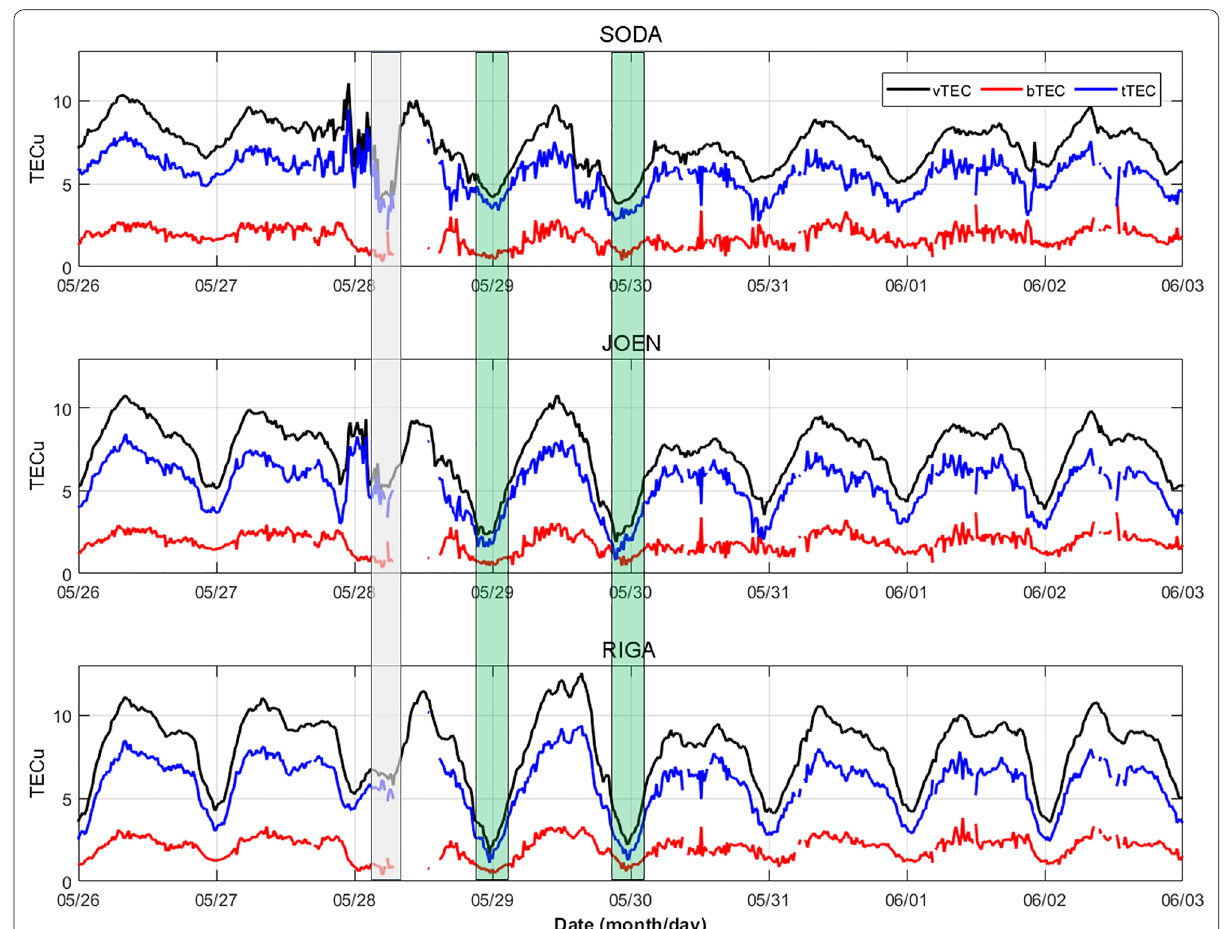
Fig. 11 vTEC (in black) as measured at SODA (67.4°N, 26.4°E), JOEN (62.4°N, 30.1°E) and RIGA (56.9°N, 24.1°E), from 26 May to 2 June 2017, in UT. SODA, JOEN and RIGA are the closest GNSS receivers to the pairs of magnetometers MUO–RAN, RAN–HAN and TAR–BRZ of the EMMA array, respectively, used to describe the latitudinal dependence of the plasmasphere dynamics as shown in Fig. 7. Corresponding values of bTEC (in red), as calculated through the IRI UP method, and tTEC vTEC bTEC (in blue), are also displayed. The gray shaded rectangle highlights the significant = − depletion of vTEC occurring in the first half of 28 May 2017, while the green ones highlight the very low values of vTEC , recorded during the nights between 28 and 29 May 2017 and between 29 and 30 May 2017, supporting the ionospheric trough movement to lower latitudes, then to lower